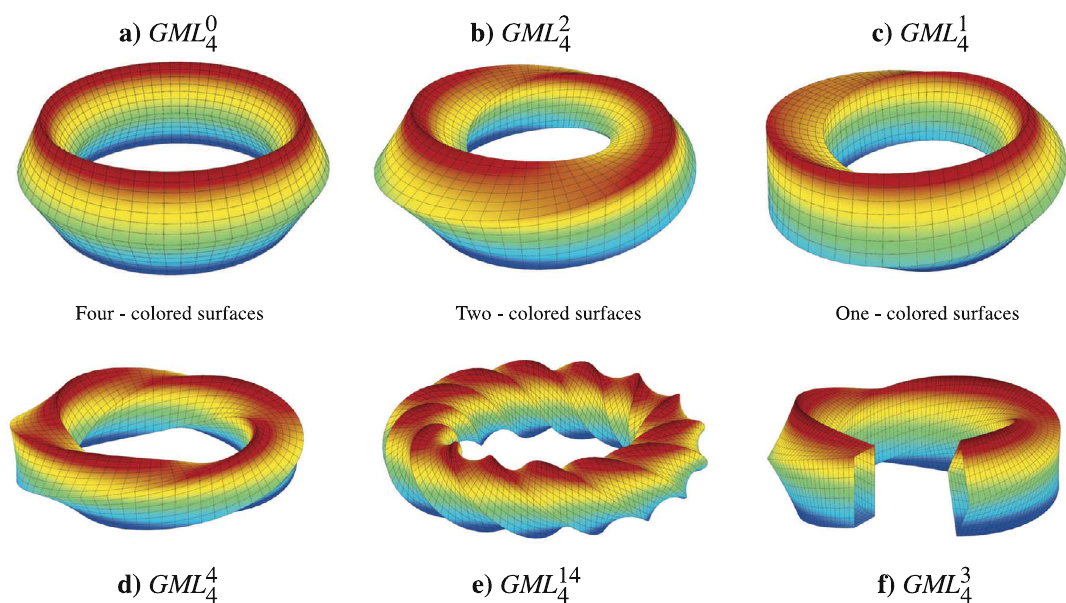
Figure 3. GML n surfaces with different values of twisting n , leading to one-, two-, or four coloured 4